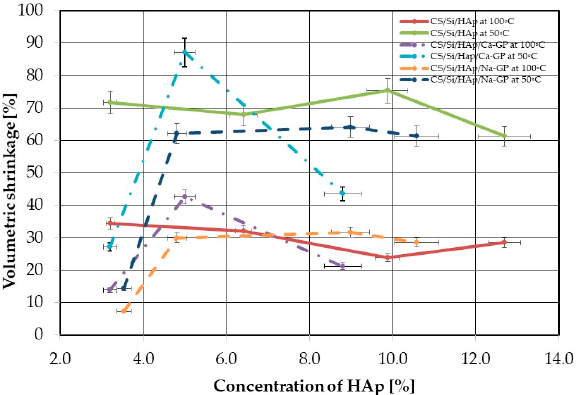
Figure 6. Volumetric shrinkage of CS/Si/HAp, CS/Si/Ca-GP, CS/Si/HAp/Ca-GP composites at dry- ing temperature of 50 and 100 °C. drying temperature of 50 and 100 ◦ CS/Si/HAp, CS/Si/Ca-GP, CS/Si/HAp/Ca-GP implants were chosen as the most promising composites for further FTIR analysis and biological studies.